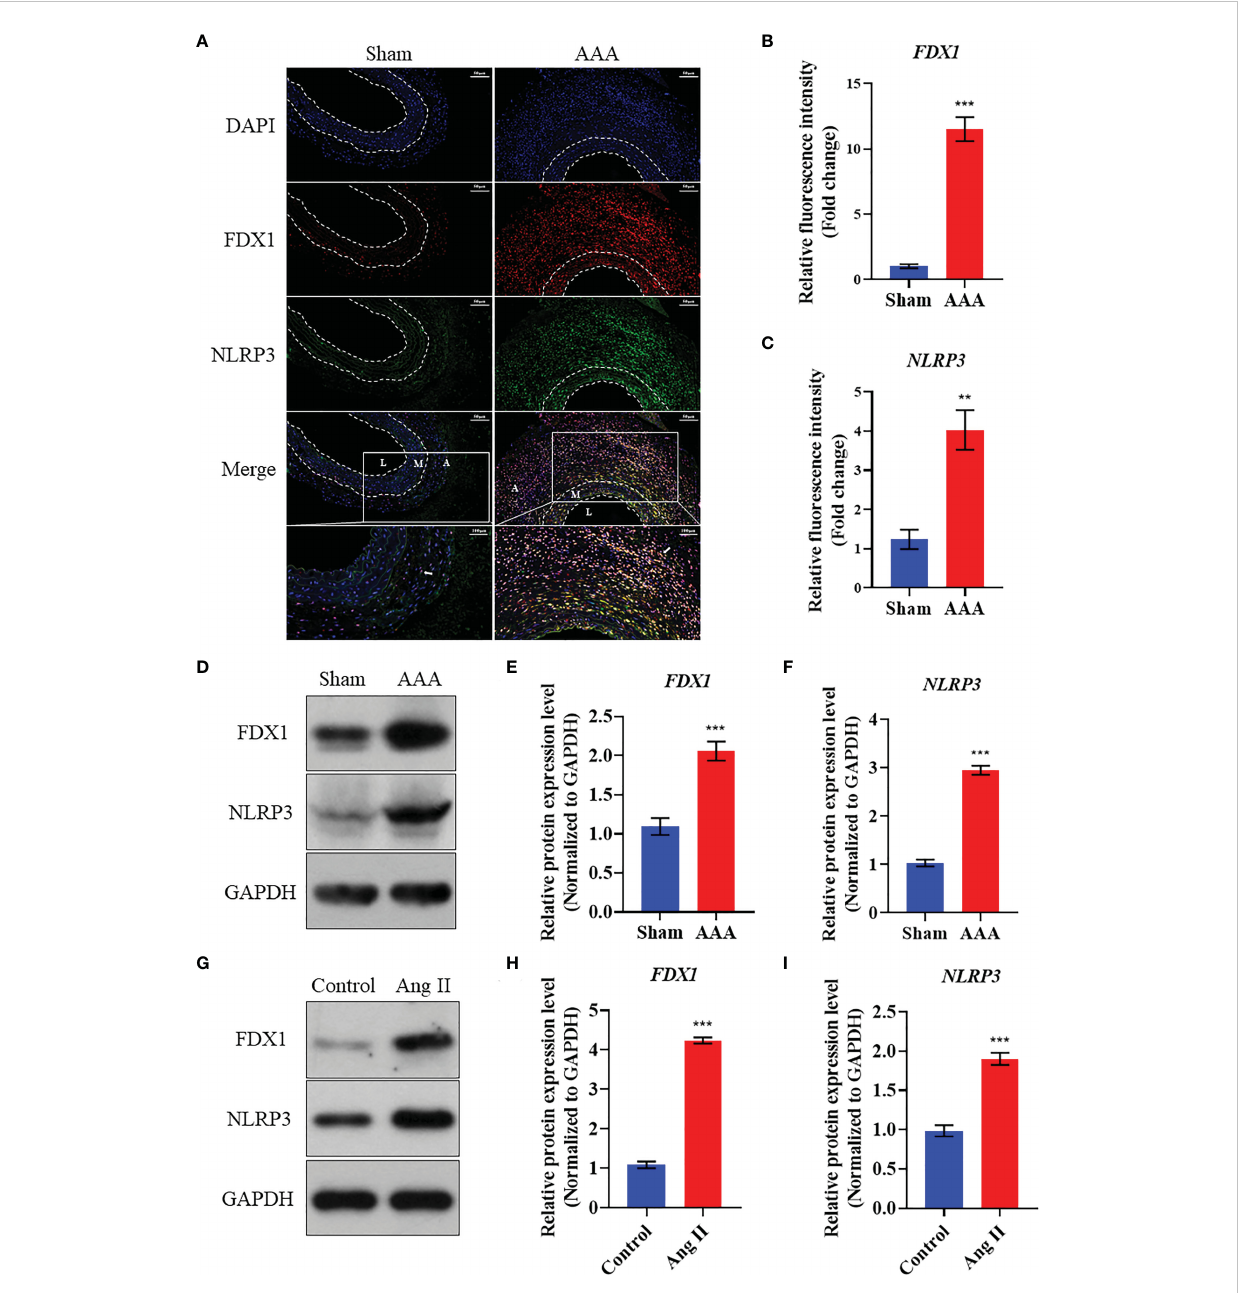
FIGURE 7 Validation of the expression of FDX1 and NLRP3 in Ang II induced AAA model. (A) The immuno fl uorescence images of FDX1 and NLRP3 on abdominal aorta in Sham group and AAA group. Scale bar, 50 m m and 100 m m. L: Tunica Lumen; M: Tunica Medium; A: Tunica Adventitia. (B) Quantitative analysis of FDX1 fl uorescence intensity in the two groups. (C) Quantitative analysis of NLRP3 fl uorescence intensity in the two groups. (D – F) Western blot analysis of FDX1 and NLRP3 on abdominal aorta in Sham group and AAA group. (G – I) Western blot analysis of FDX1 and NLRP3 on VSMCs in Control group and Ang II group. Repetition=3, **p value < 0.01, ***p value <